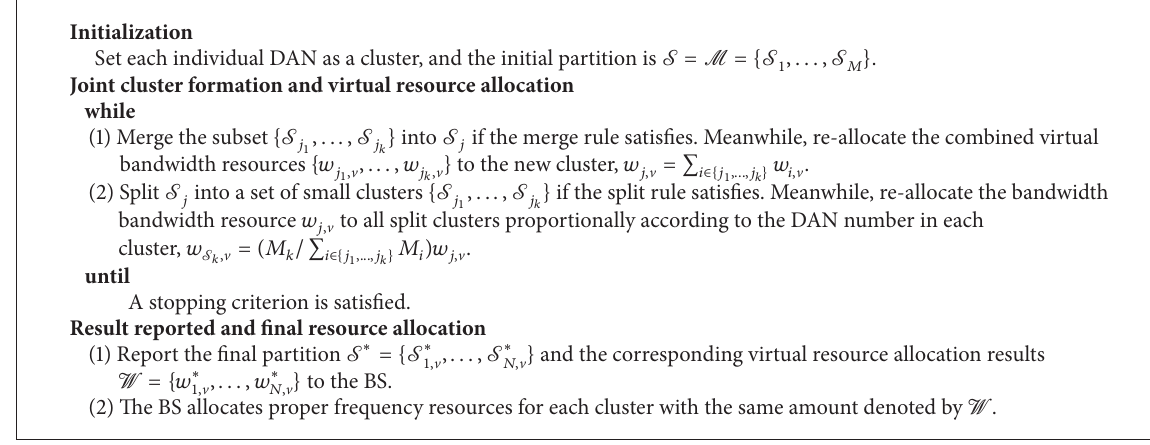
Algorithm 1: Implementation of the joint cluster formation and resource allocation